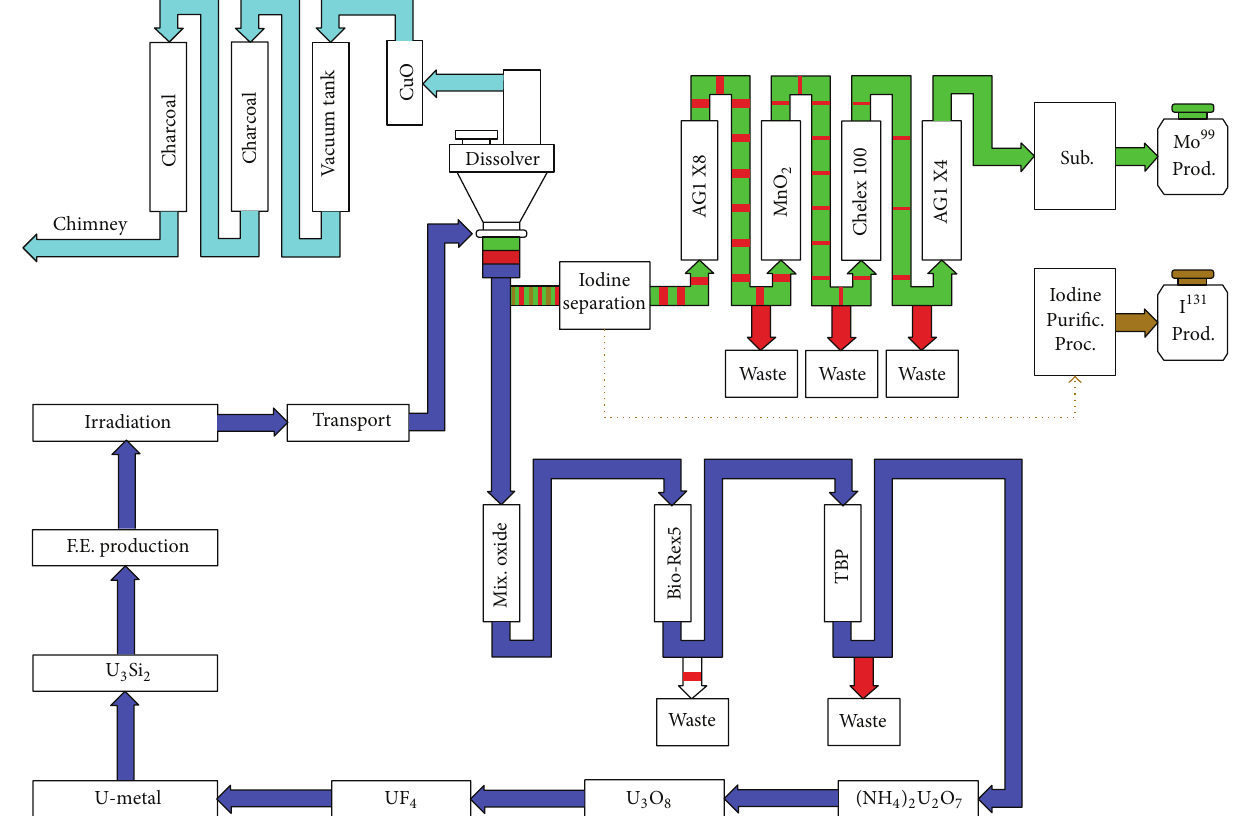
Figure 5: Process scheme of complete and closed KSS process variant (taken from [23]), completely proven with U 3 Si 2 -Al dispersion targets.